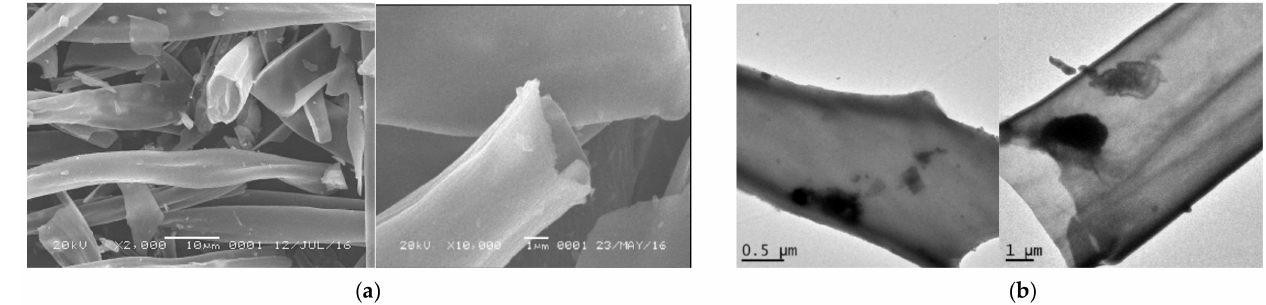
Figure 3. The SEM ( a ) and TEM ( b ) images of the novel magnetic solid acid. The BET surface area of the novel magnetic solid acid was as high as 215 m 2